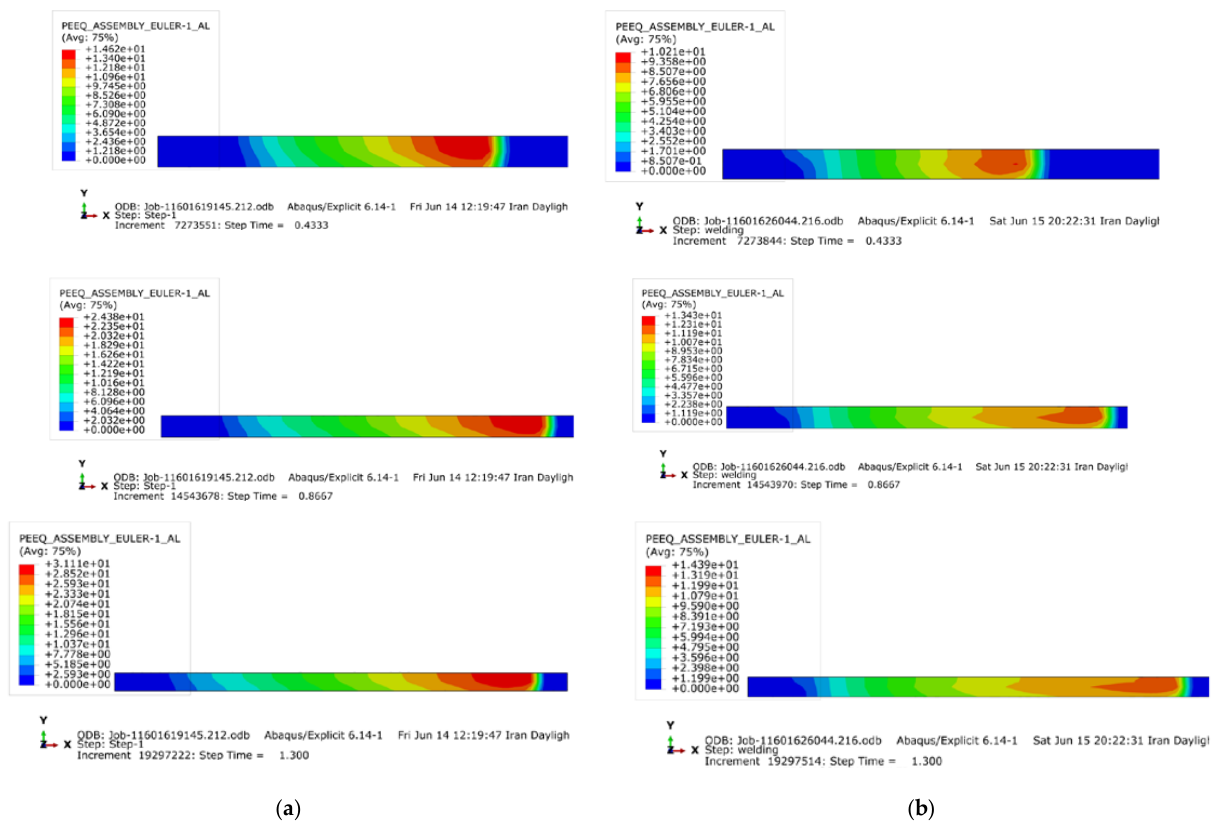
Figure 14. The longitudinal view of the equivalent plastic strain ( a ) with tilt Angele; ( b ) without the tilt angle.